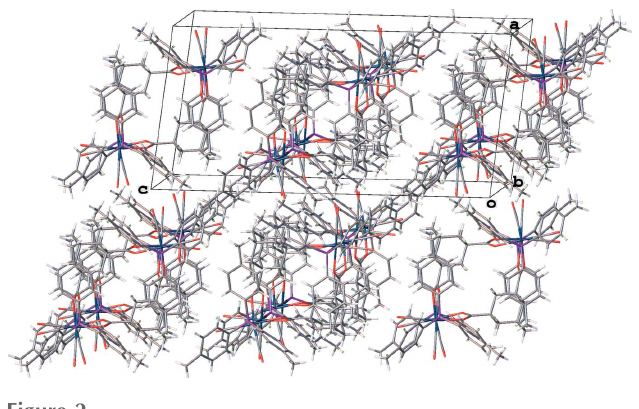
Figure 2 Packing of the title molecules viewed approximately along the b axis.